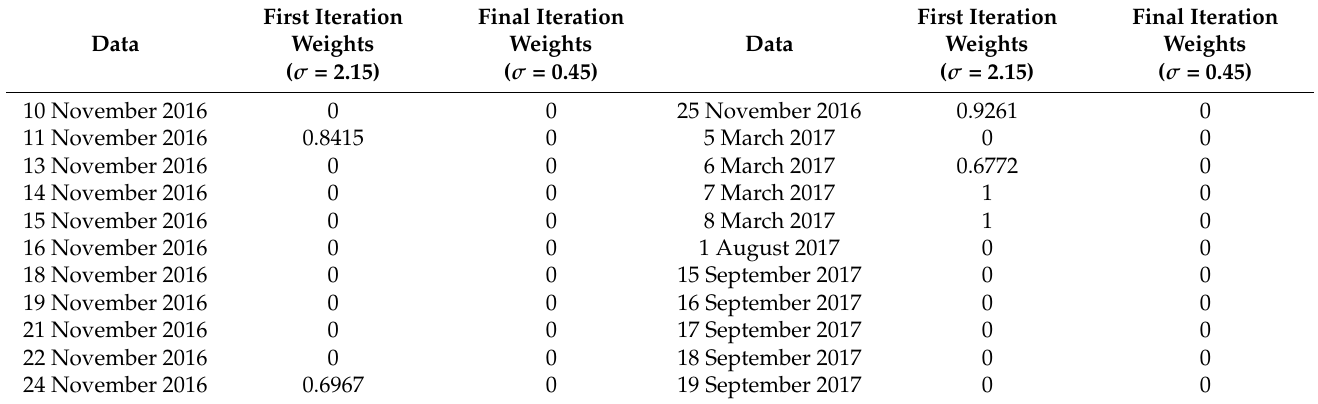
Table 3. Table of initial and final iteration weights of gross